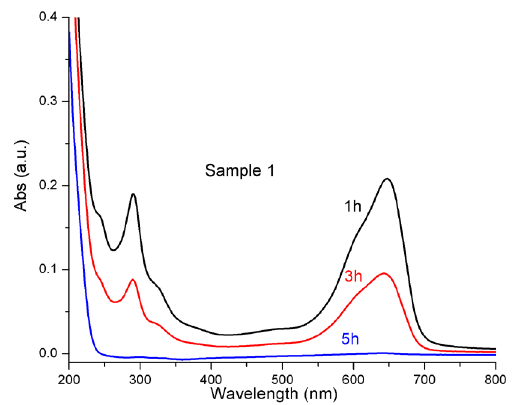
Figure 10. The photocatalytic activity of sample 1 (degradation of